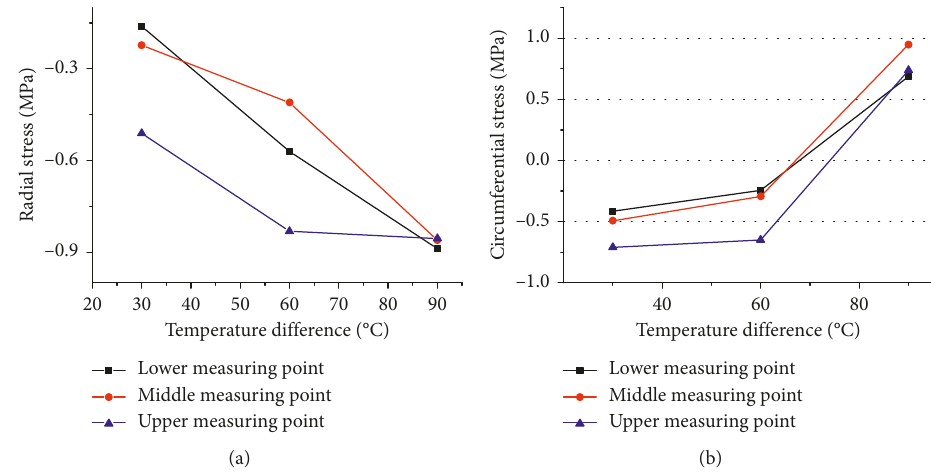
Figure 11: Maximum thermal stress under different heating temperatures. (a) Radial stress. (b) Circumferential